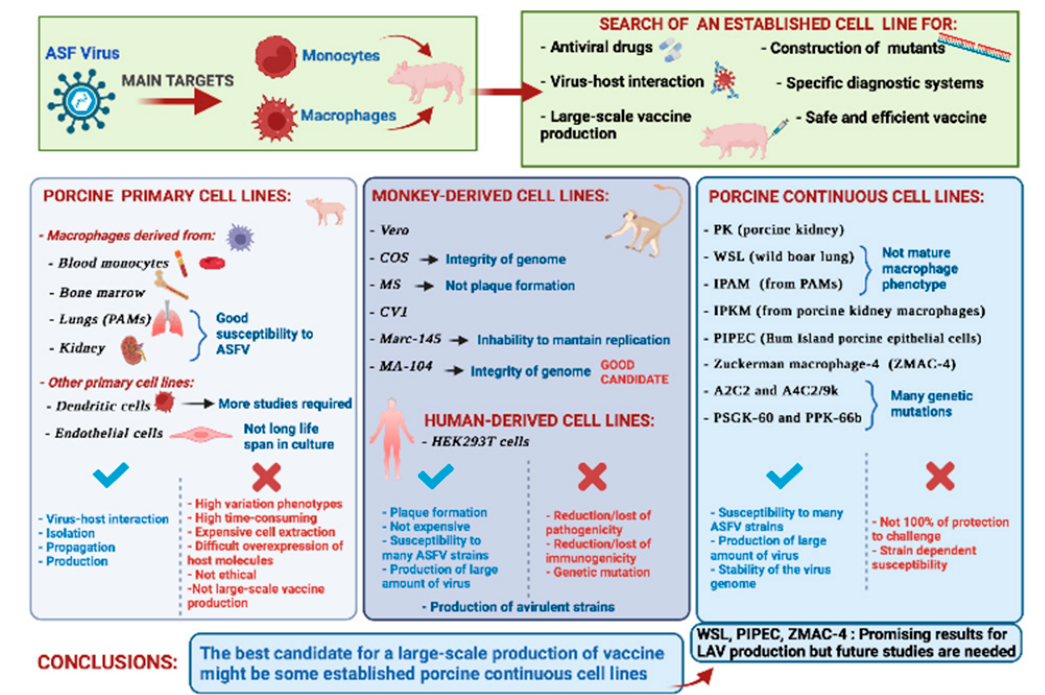
Figure 3. Primary and continuous cell lines tested for ASFV susceptibility. The main targets of ASFV are porcine monocytes and macrophages. Established cell lines were tested to support virus growth for the production of antiviral drugs, virus–host interaction studies, the construction of mutants, specific diagnostic systems, and the large-scale production of a safe and efficient vaccine. The established cell line has to have susceptibility to several ASFV strains, be not expensive to produce or time-consuming, be ethical, and able to maintain the genome stability of the virus. Considering all the cells tested thus far, the most promising continuous cell lines for LAV production are WSL, PIPEC, and ZMAC-4; however, future studies are still needed. Created with BioRender.com (accessed on 7 March 2022). PAMs: porcine alveolar macrophages; IPAM: immortalized porcine alveolar